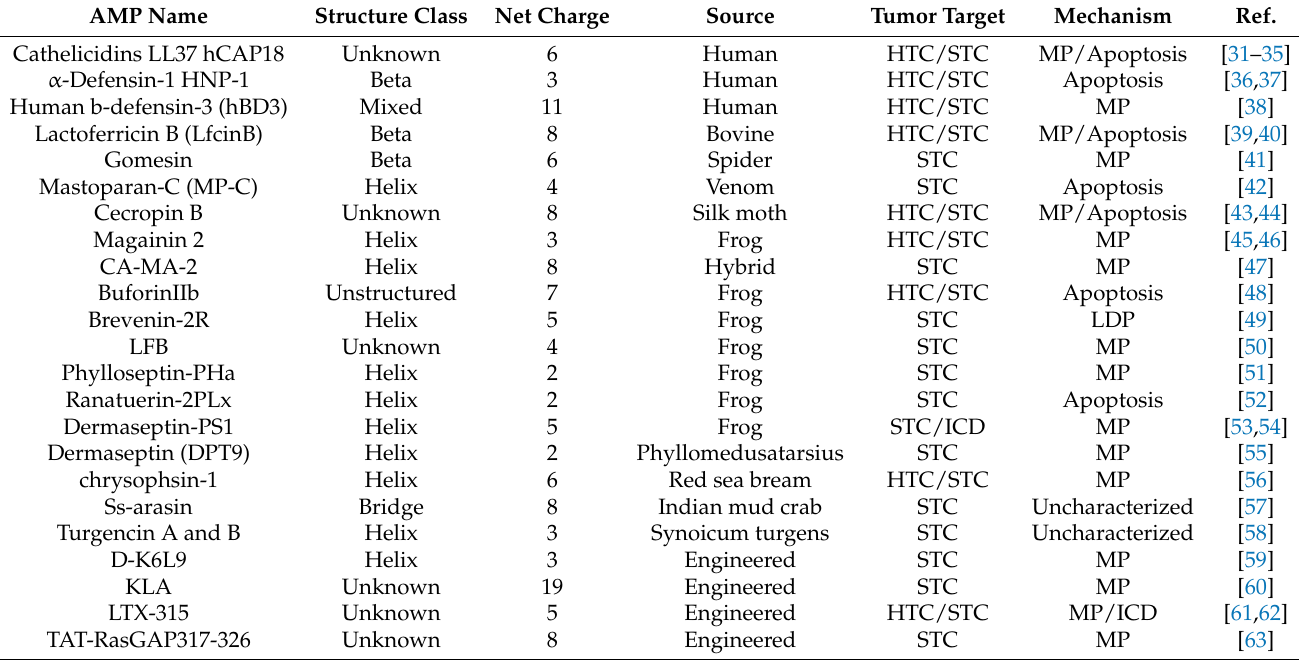
Table 1. List of the most representative antimicrobial peptides also effective as anticancer